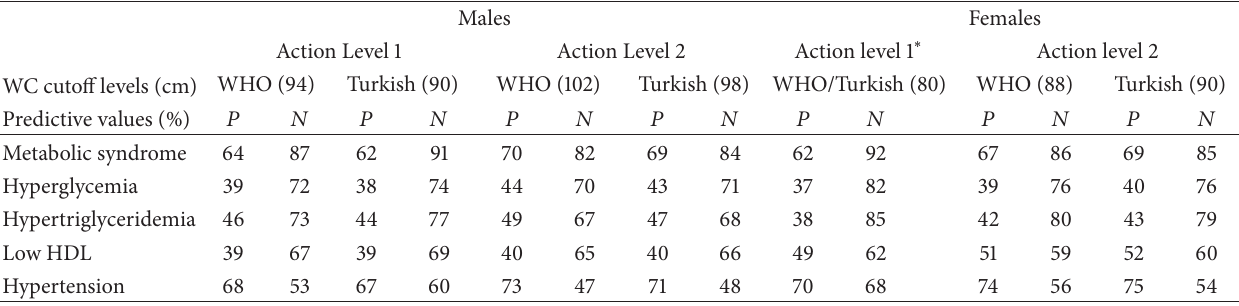
Table 2: The positive and negative predictive values of different waist circumference cutoff points for metabolic syndrome and its individual components.